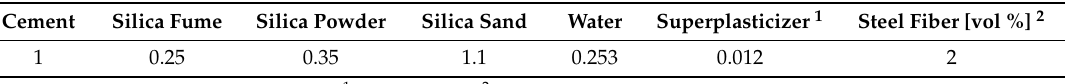
Table 1. Mix proportion of prepared ultra-high performance concrete (UHPC) (wt % of cement).